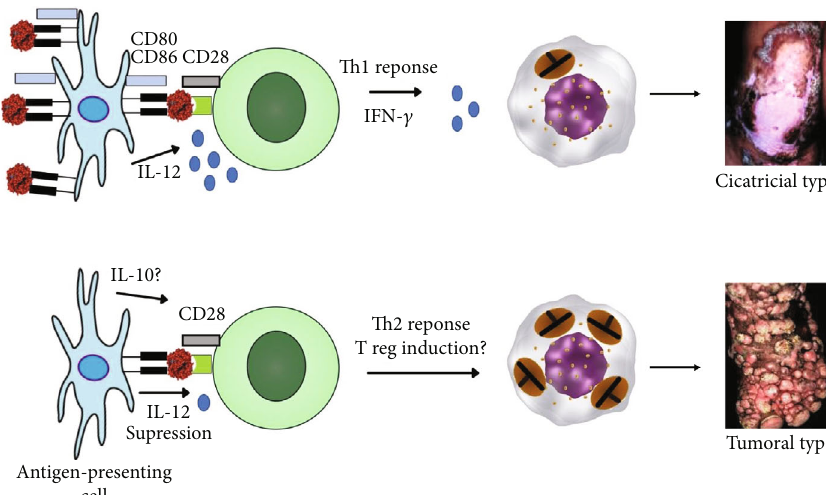
Figure 5: Acquired immune responses and outcome of CBM infection. Communication between APC and CD4 T cells involving MHC- TCR; costimulatory molecules (CD80/86 – CD28) and IL-12 drive the development of a Th1 immune response and mild forms of CBM, such as the atrophic clinical type. On the contrary, the low expression of MHC class II associated with a lack of costimulatory response and low levels of IL-12 drives the immune response to a Th2 immune response, muriform cell multiplication, and disease